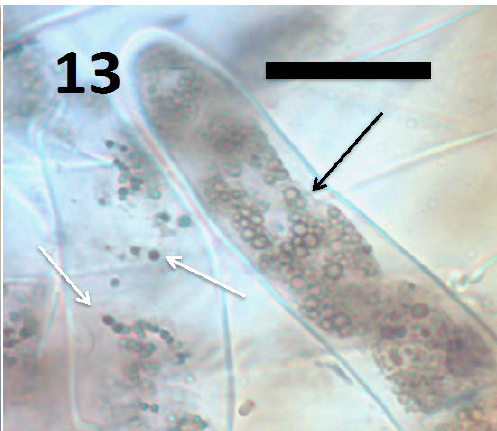
Figure 13. Root hairs of grass Cynodon dactylon seedling showing B. amyloliquefaciens (arrows) in hair (stained with 3,3-diaminobenzidine followed by aniline blue). The smaller blue-staining spherical structures (white arrows) are L-forms with cytoplasmic proteins intact; while larger spherical structures (black arrows) are oxidized L-forms that are swollen and lack cytoplasmic proteins, and as a consequence do not stain blue internally (bar = 20 µm).